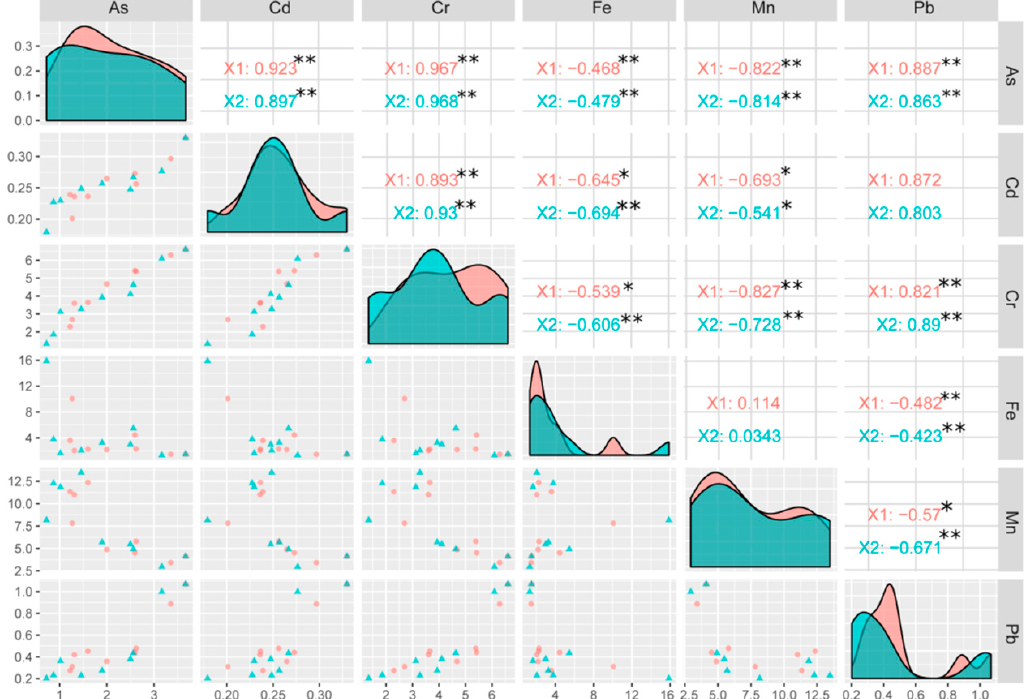
Figure 4. Correlation between total concentrations of di ff erent elements in plants.